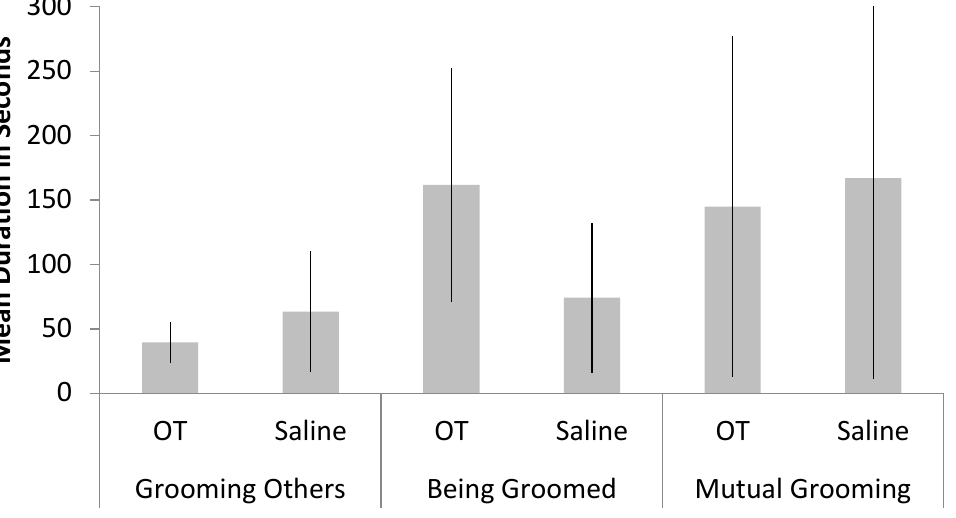
Figure 1 . Mean duration of grooming behaviors by condition. We failed to find significant differences between our oxytocin (OT) and saline conditions in regards to any social grooming behaviors. There was a high degree of individual variation, as indicated by the SEM